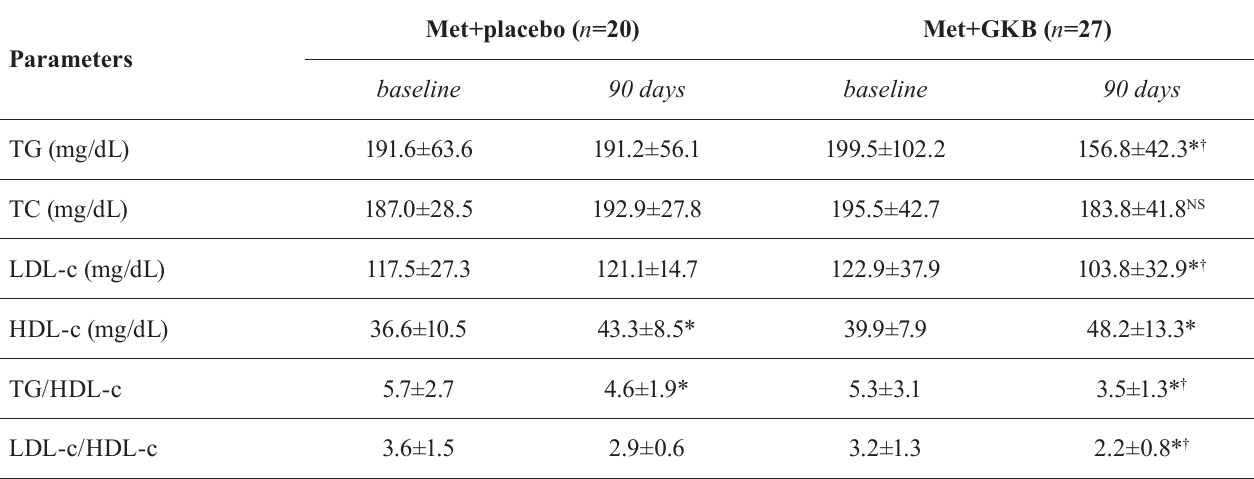
TABLE II - Changes in the lipid profile of T2DM patients maintained on metformin and treated with Ginkgo biloba extract